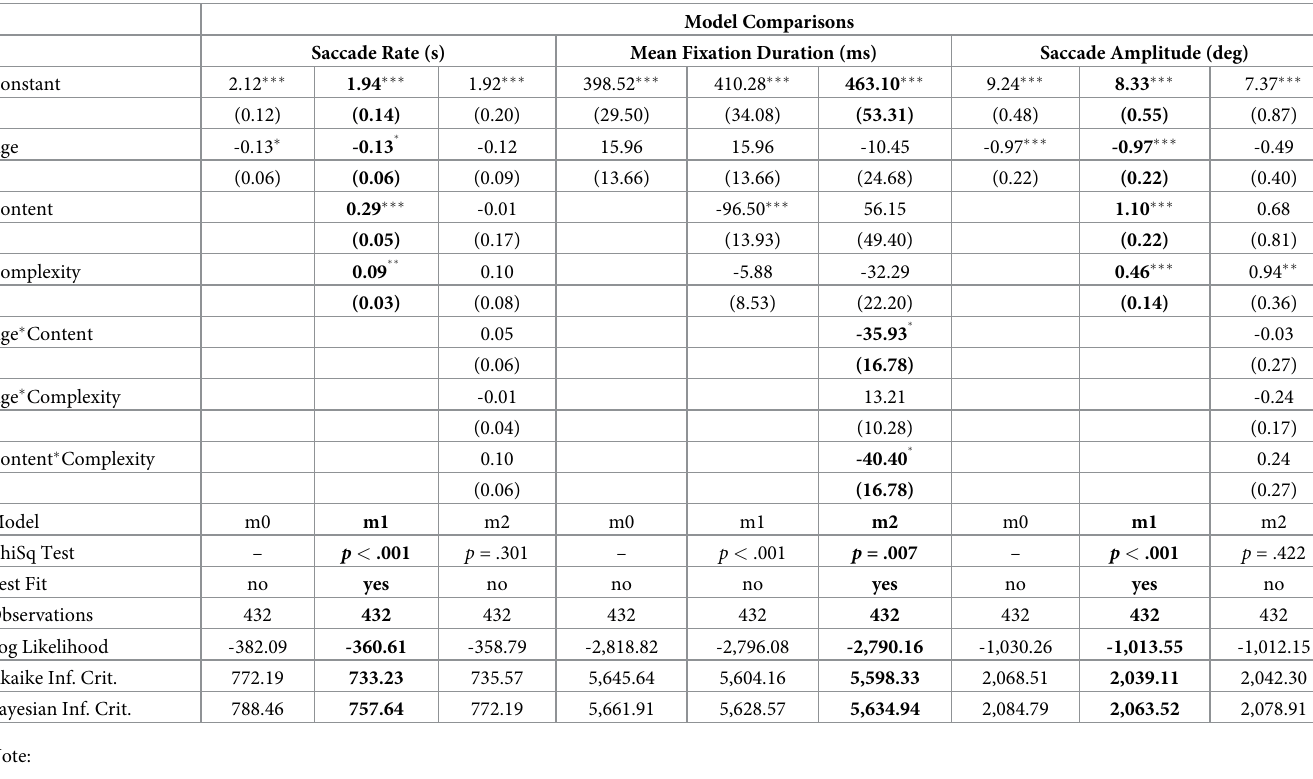
Table 4. Experiment 2 estimates and standard error for all model effects. Significant effects for best-fitting model noted in bold.